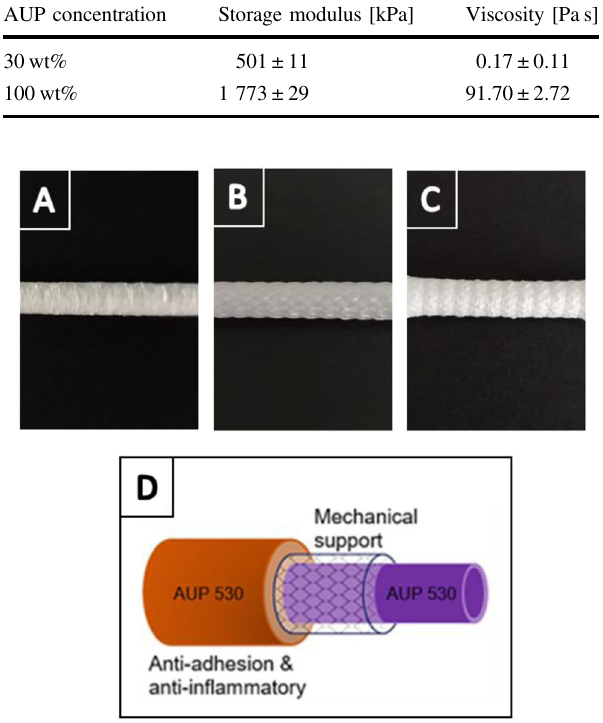
Fig. 4 Visualization of a reinforced, drug-loaded ES repair construct. A Inner layer with no additional drugs that serves at enclosing the tubular braid in between two electrospun layers. B Tubular braid with a Chinese fi nger trap mechanism that acts as a mechanical support. C Outer layer with incorporated anti-adhesion and anti-in fl ammatory components. D Schematic visualization of the multi-layered repair construct. PCL was used as a